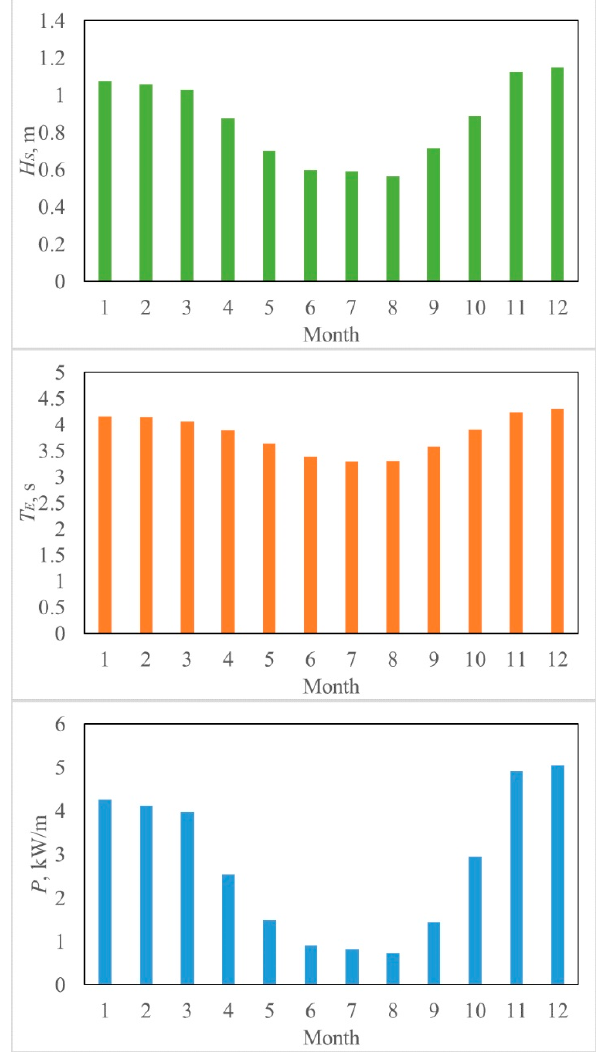
H ( top ), T ( middle ) and P ( bottom ) for L6. S E